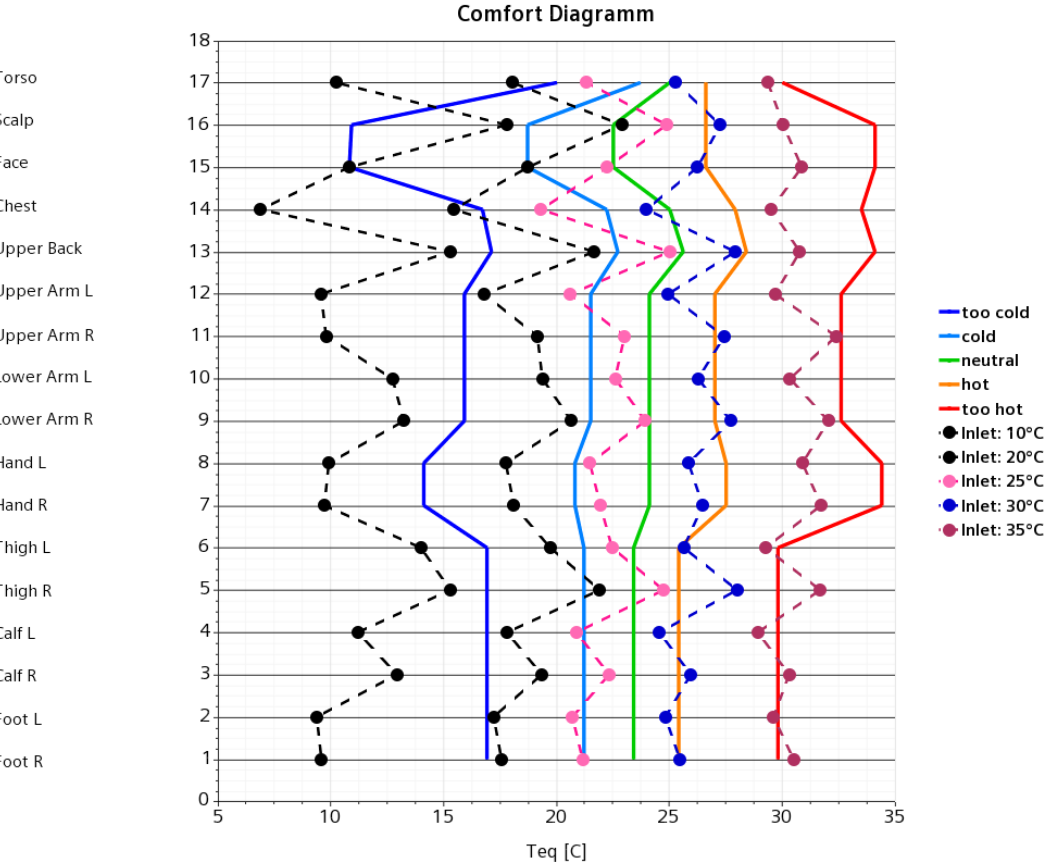
Figure 12. Equivalent temperature cubic room test case. Dotted lines for visual purposes.